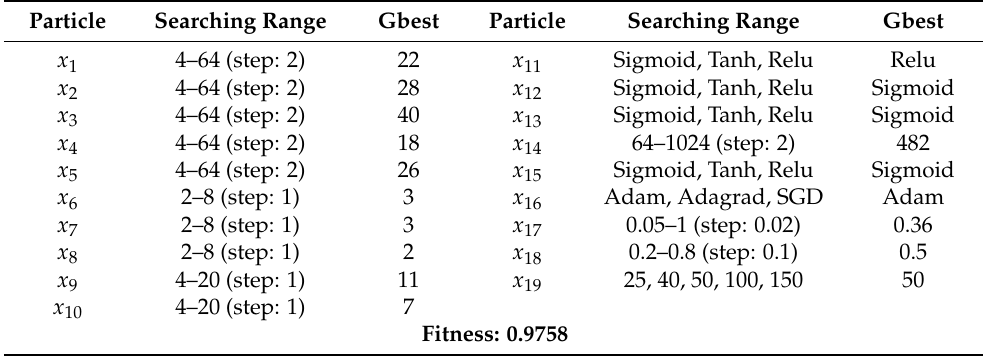
Table 3. Optimal hyper-parameters of FCNN.